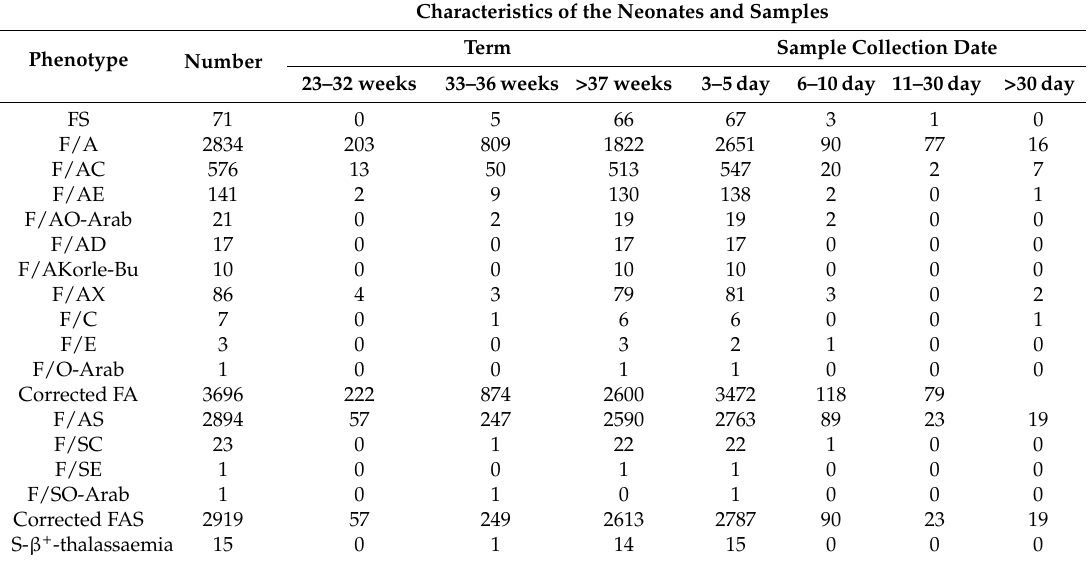
Table 1. Characteristics of the newborns and samples. Characteristics of the Neonates and